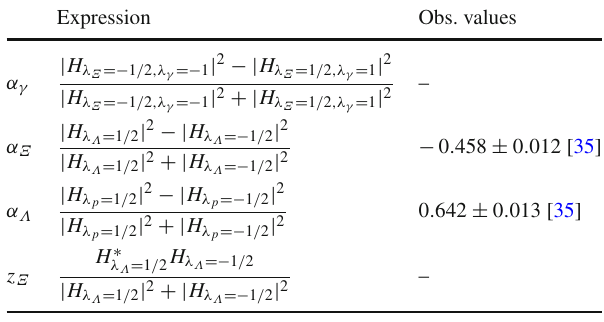
Table 1 Definition and measured values of the decay parameters and photon polarization used in Eqs. (2) and (4) Expression Obs. values